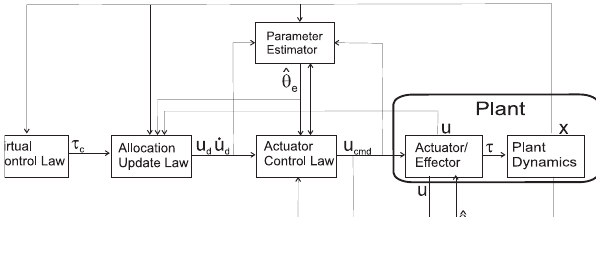
Figure 1: The closed loop diagram of the certainty equivalent control allocation algorithm